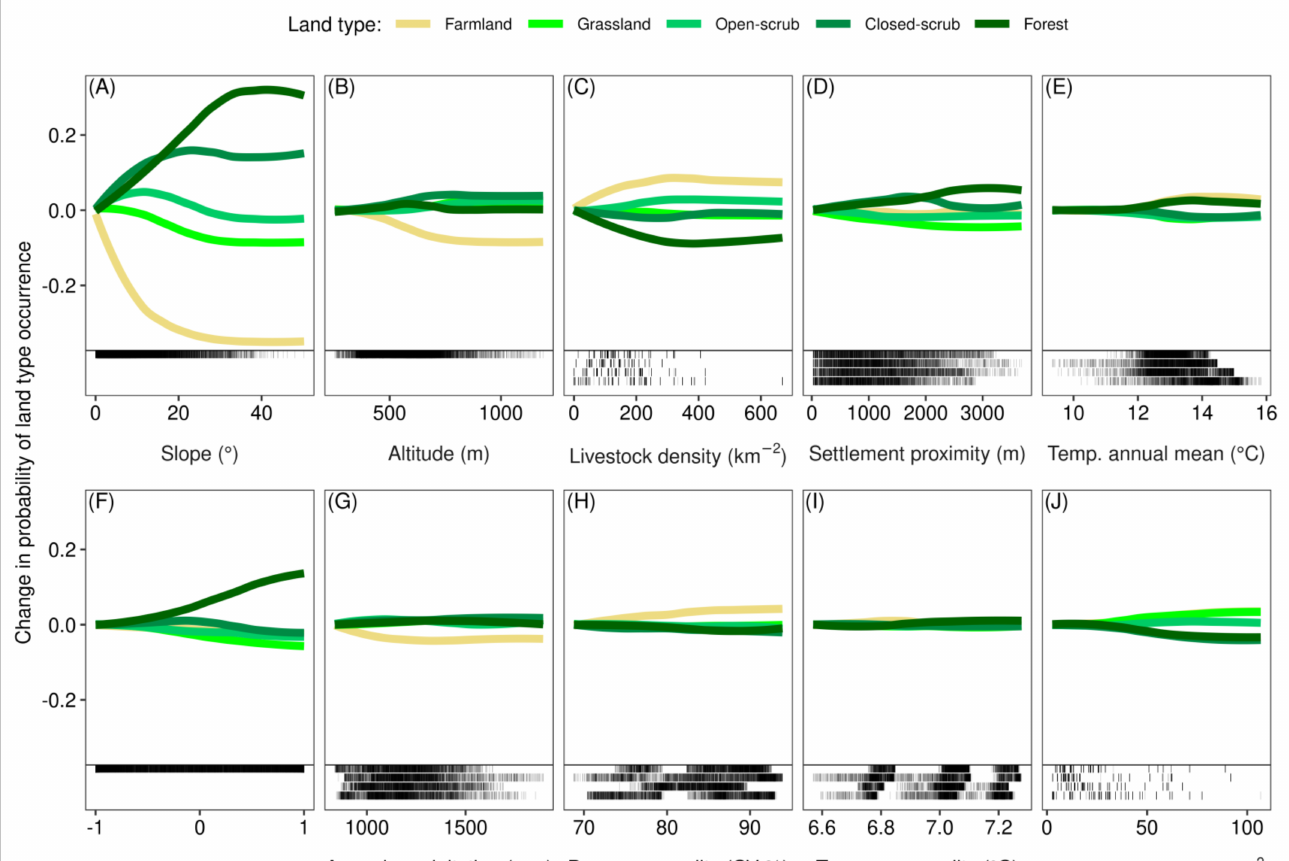
Figure 4. Mean marginal effects of the top 10 predictors ordered in decreasing importance for LUC type classification by the Random Forest model (panels ( A – J )). For comparability, the curves are centred to the mean prediction for the left-most, minimum value of each predictor. The vertical marks under the horizontal line show the predictor’s values in the training. If a predictor took different values in different years, the vertical marks are stacked in four rows, each row for a year, 1945 to 2015 from top to